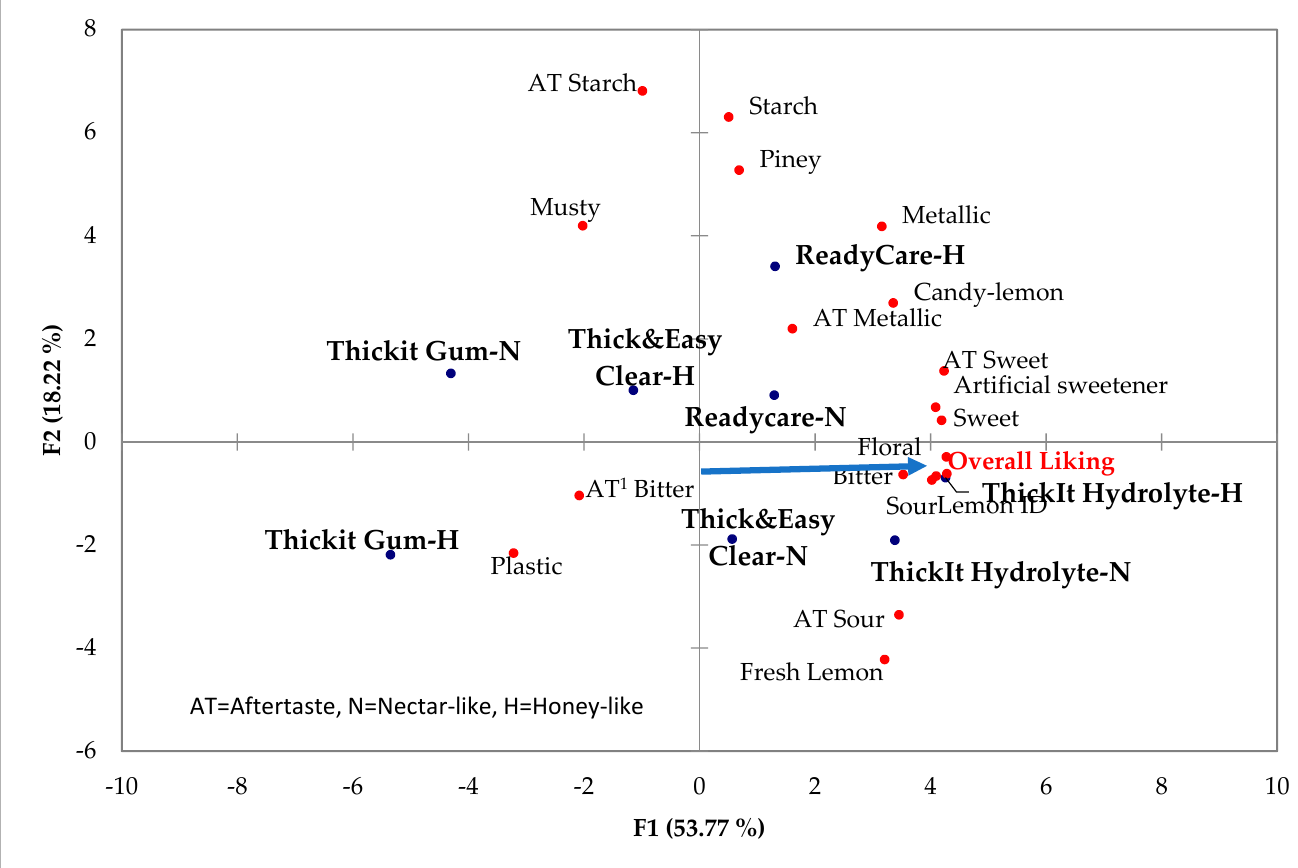
Figure 2. External preference mapping (flavor and aftertaste).